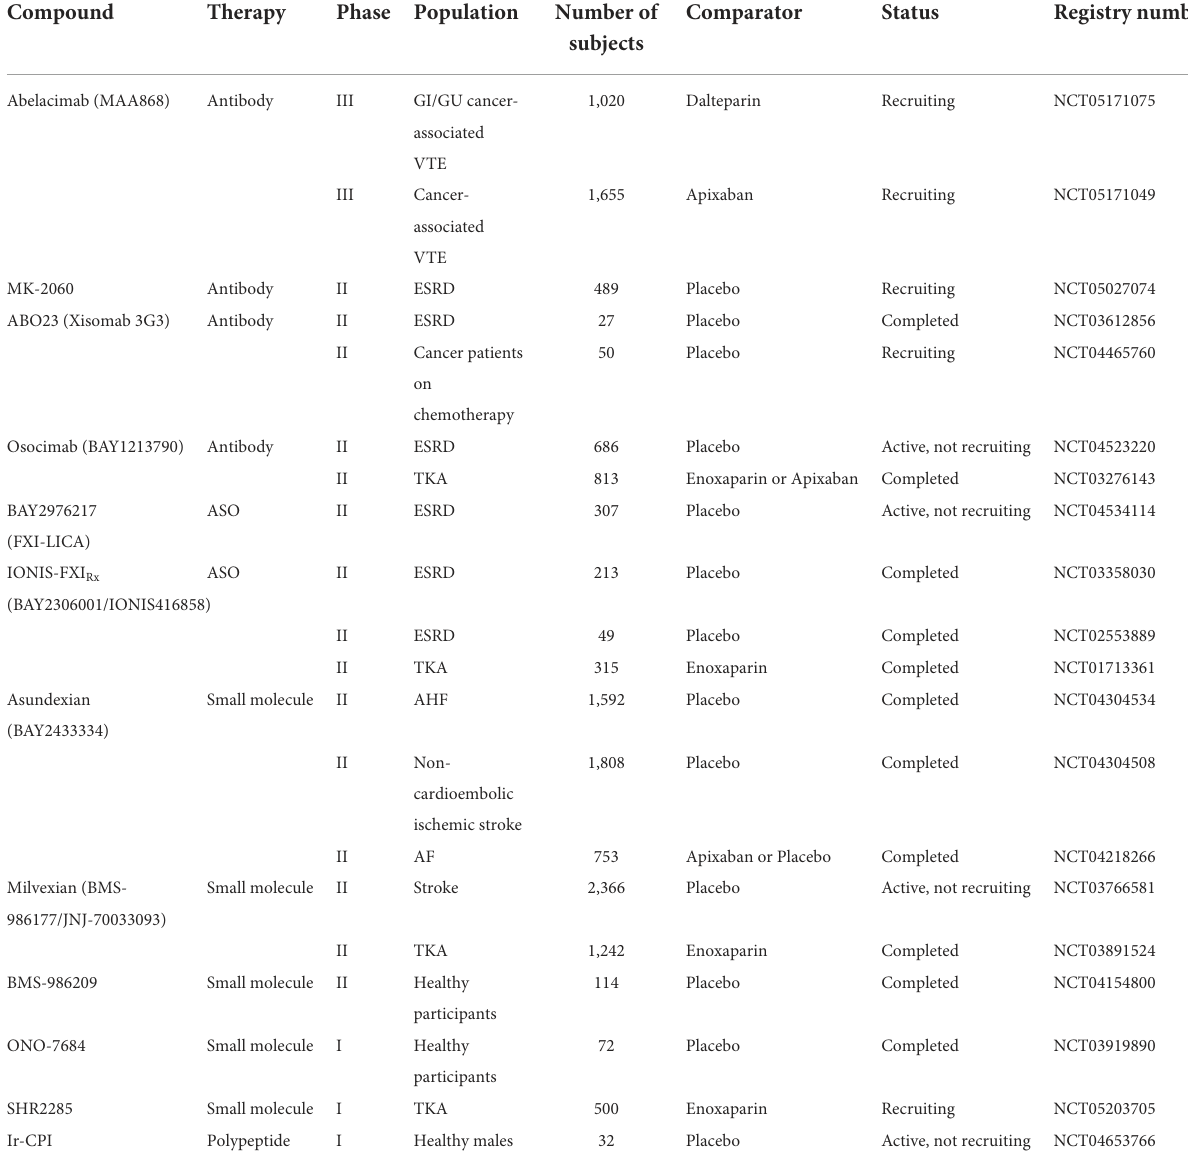
TABLE 2 Overview of factor XI-targeting inhibitors currently in clinical